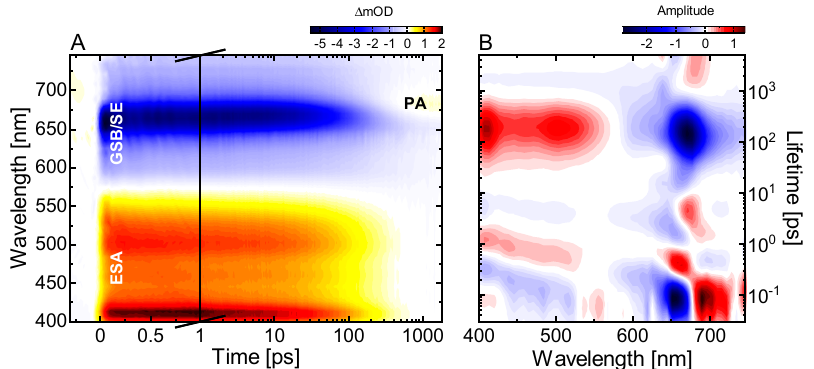
Figure 2. Ultrafast excited state dynamics of the P r state in Syn Cph2 investigated in the vis spectral range. ( A ) TA data of the P r → P fr dynamics after excitation at 640 nm. ( B ) Corresponding lifetime density map (LDM) obtained from the lifetime distribution analysis of the TA data displayed in ( A ). The GSB signal coincides with the ground state absorption spectrum in Figure 1.